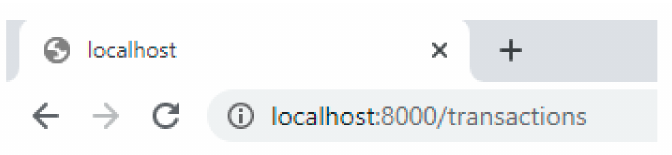
Figure 10. Run local host: 8000 for adding updated transaction in the distributed power chain of control